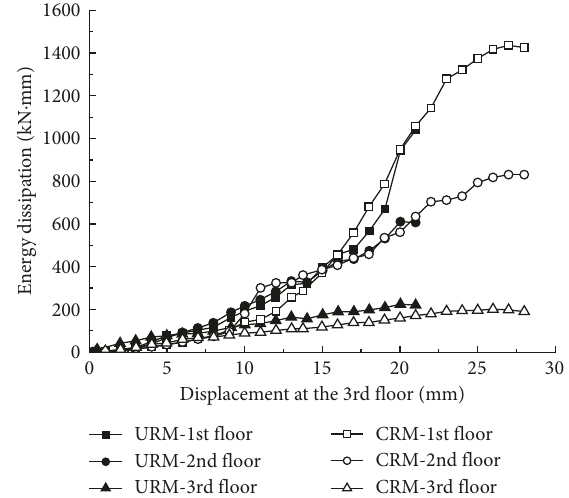
Figure 14: Energy dissipation of both URM and CRM wall.